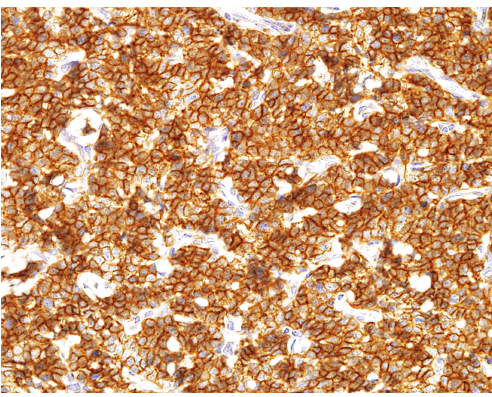
Figure 13: The undi ff erentiated small cell component in mesenchy- mal CHS strongly positive for